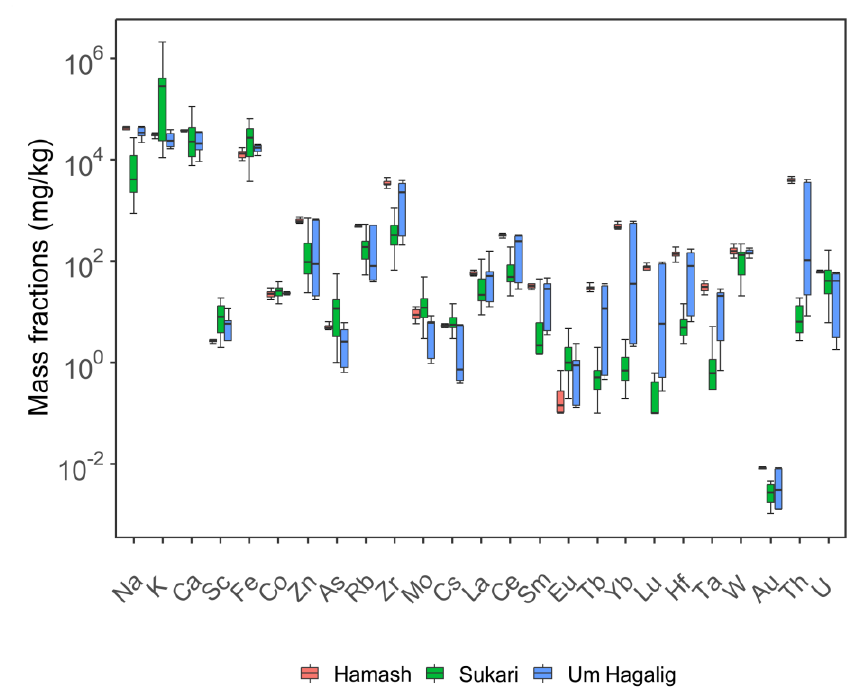
Figure 5. Mass fractions of the determined elements in the investigated mines.